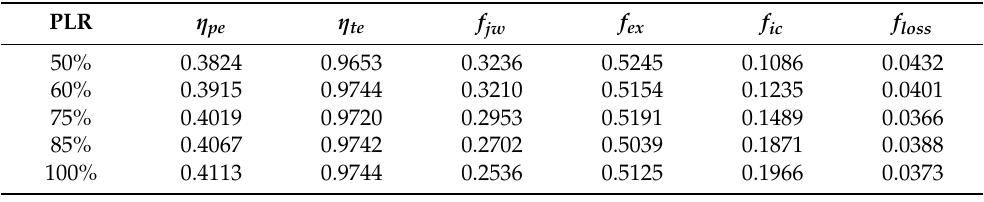
Table 1. Performance factors of ICE.